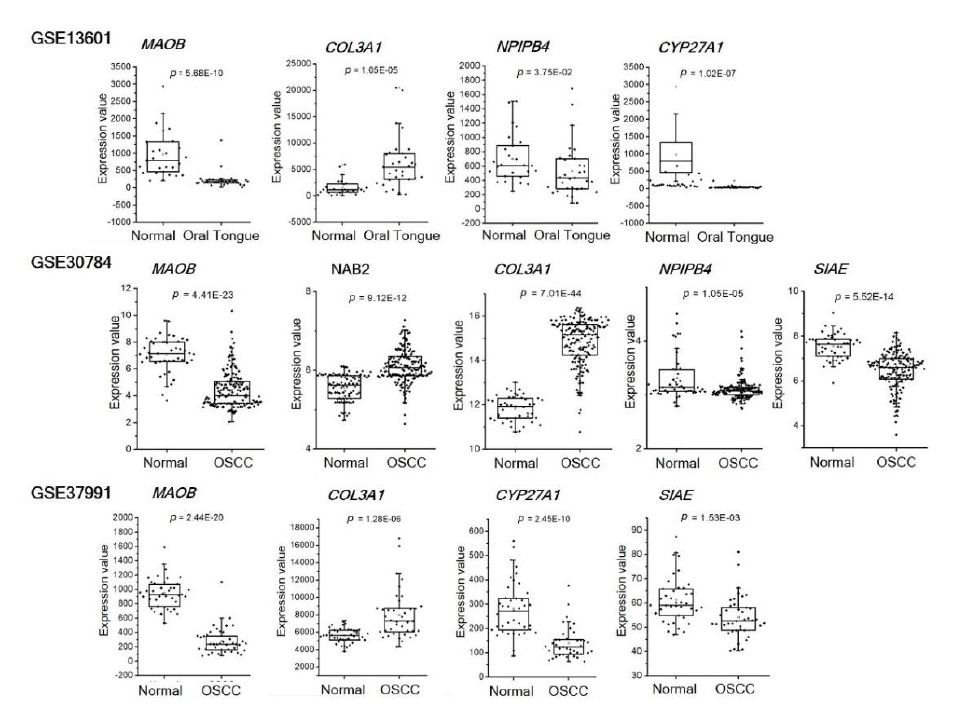
Figure 4. Expression profiles of the candidate mRNAs in OSCC tumor tissues. The expression patterns of the candidate genes in OSCC tumor tissues and non-tumor control tissues were extracted from gene expression datasets of three independent microarray databases (GSE13601, GSE30784, and GSE37991) at NCBI GEO website. The GSE13601 dataset contains data for tumor and matched normal controls from oral tongue SCC patients ( n = 20). The GSE 30,784 contains data for OSCC ( n = 167) and normal oral tissues ( n = 45). The GSE37991 contains tumor and non-tumor pair-wise sample data from 40 male OSCC patients.